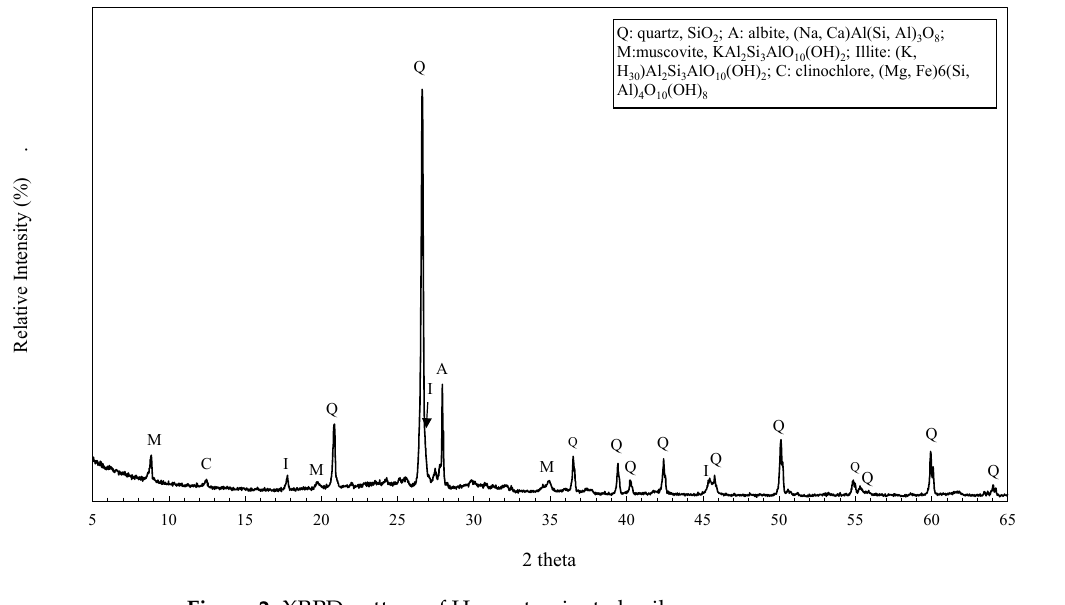
Figure 2. XRPD pattern of Hg contaminated soil.